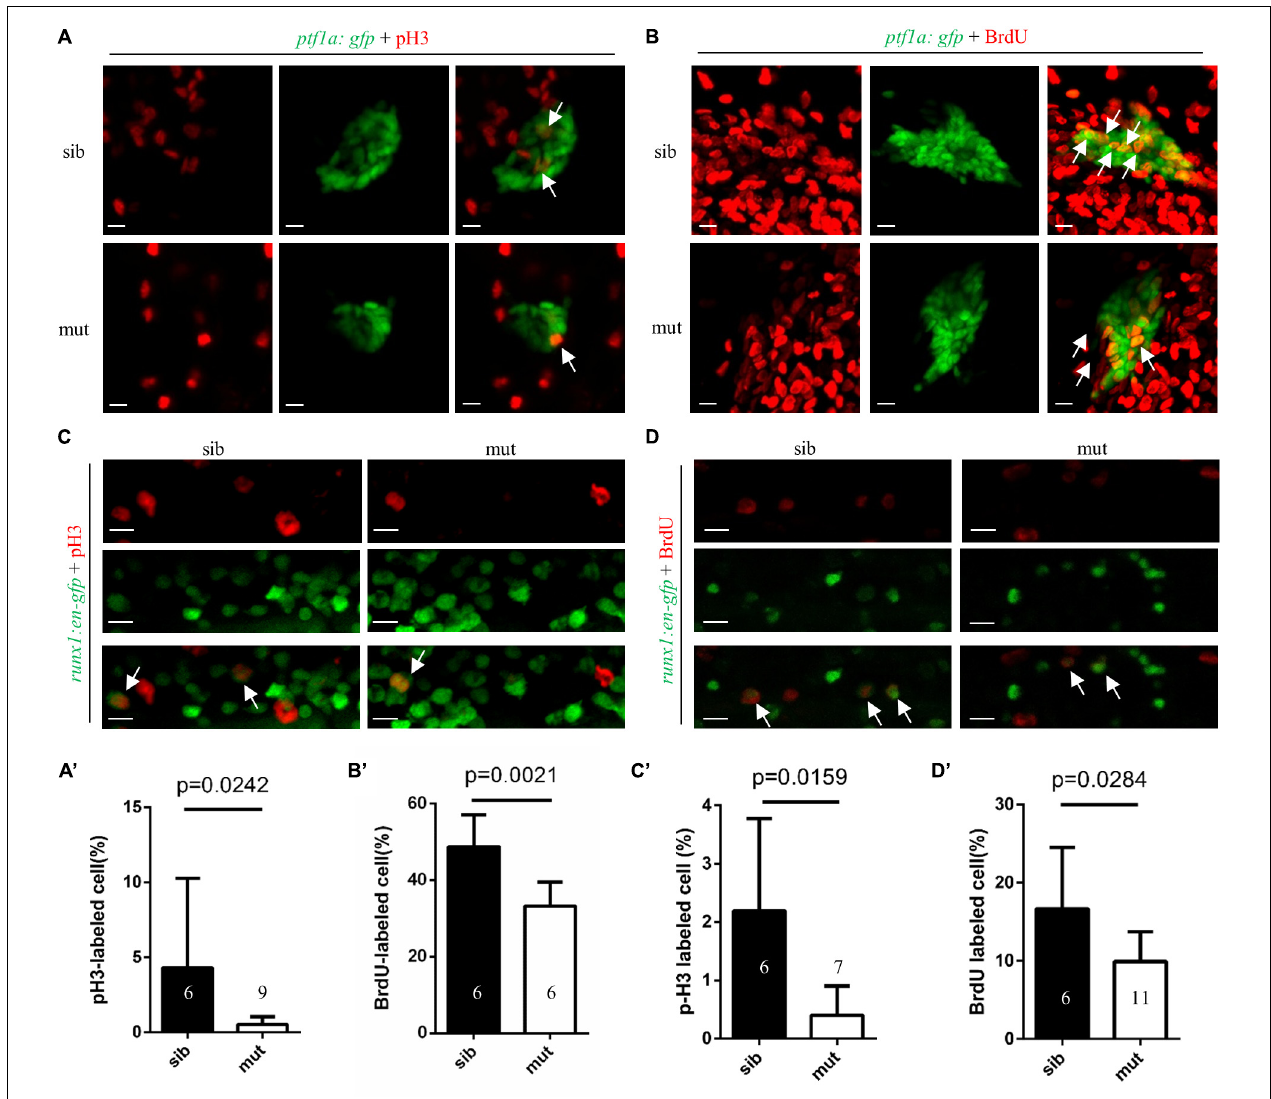
FIGURE 4 | Impaired proliferation of exocrine pancreas progenitors and HSPCs in ltv1 ∆ 14 /∆ 14 mutant. (A,B) Representative confocal images of pH3 immunostaining (A) or BrdU labeling (B) in ltv1 ∆ 14 /∆ 14 ; ptf1a:gfp mutants and siblings at 2 dpf. (A’,B’) The percentage of pH3 + (A’ , siblings, N = 6; mutants, N = 9) or BrdU + ( B’ , siblings, N = 6; mutants, N = 6) cells within the ptf1a + population in ltv1 ∆ 14 /∆ 14 mutants and siblings at 2 dpf. Bars represent means with SD. (C,D) Representative confocal images of pH3 immunostaining (C) and BrdU labeling (D) in ltv1 ∆ 14 /∆ 14 ; runx1:en-gfp mutants and siblings at 2.5 dpf. (C’,D’) The percentage of pH3 + ( C’ , siblings, N = 6; mutants, N = 7) and BrdU + ( D’ , siblings, N = 6; mutants, N = 11) cells within the runx1 + population in ltv1 ∆ 14 /∆ 14 mutants and siblings at 2.5 dpf. Bars represent means with SD. White arrow: merged cell. Scale bar: 10 µ